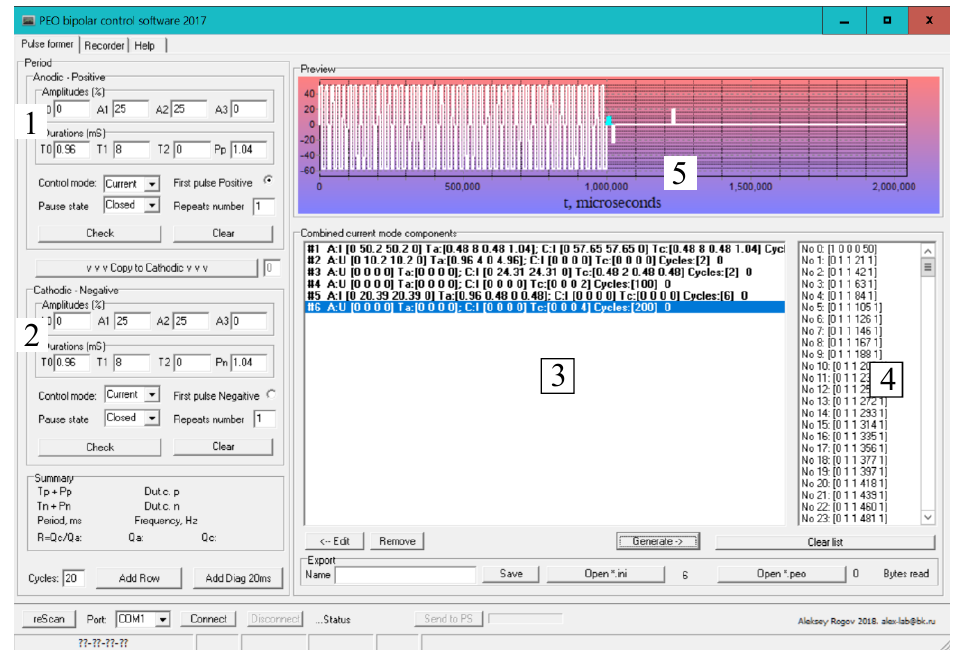
Figure 8. Appearance of regime designer software. Legend: 1, 2—parameters of anodic and cathodic pulses, respectively; 3—list of regime elements for editing; 4—list of set points; 5—simplified preview of the waveform.